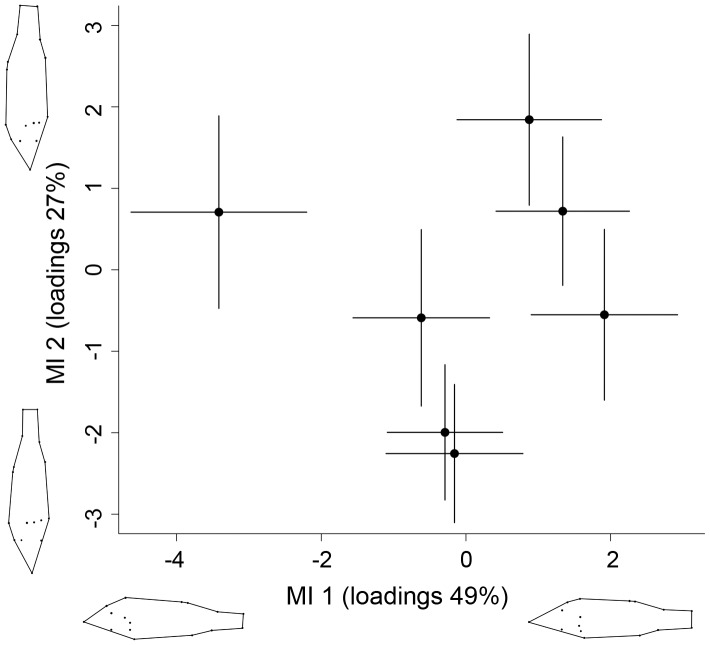
Morphological variation across lakes.Variation (mean ± 1SD) along the first (MI1) and second (MI 2) morphological axis across all surveyed lakes. Deformation plots (uniform and non-uniform components) corresponding to variation in MI 1 and MI 2 are shown beside the axes.